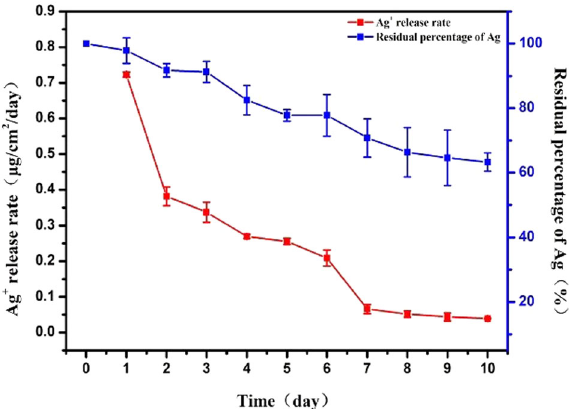
Fig. 9 Ag + release rate and residual percentage of H-SCNF/Ag- 0.01. Error bars represent standard deviations using at least two measurements from two different